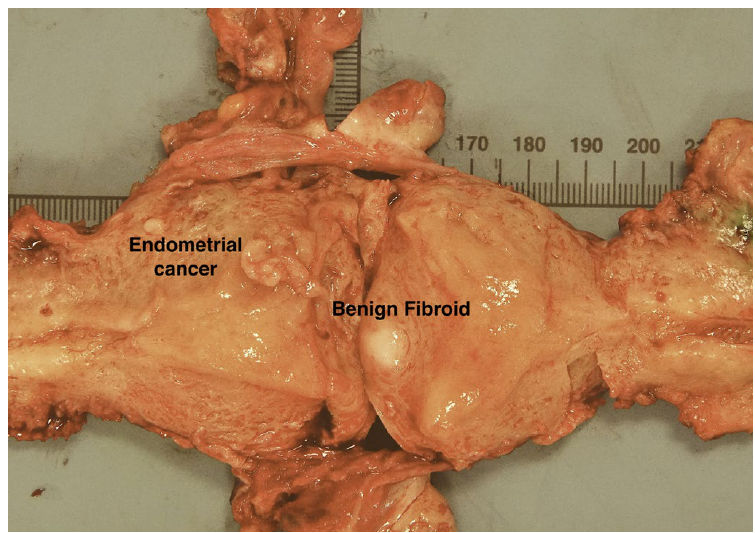
Figure 6. Case 2. Uterus bisected along its lateral walls showing a fleshy polypoid endometrial carcinoma arising from the left lateral fundus, in the region of the left cornua. The bulk of the tumour was removed during diagnostic hysteroscopic endometrial curettage. Scale is in mm. Collectively, these results are consistent with the preop urine MSI signal being from the tumour, and subsequent analysis of VAFs within the preop, postop, and tumour bi- opsy samples estimated that over 60% of the cfDNA in the initial preop urine was tumour- derived (Figure 5B). In addition, only the first preop urine, vaginal swab, and tumour samples were classified as MSI-H, with all other urine samples and control tissues classi- fying as MSS (Figure 5C). 4. Discussion We have shown that an mPCR amplicon sequencing assay can classify CRC MSI sta- tus and detect BRAF variants with a high level of concordance relative to existing diag- nostic methods, and that it can be used to detect MSI in colonoscopic biopsies. Knowledge of biopsy MMR status could facilitate clinical decision making and LS diagnosis, and establish the MMR status of tumours where surgery is not performed. Our original MIP assay classified CRCs with as little as 3% MSI-H template in mixing experi- ments [31], and composite biopsy templates analysed here gave assay scores comparable to matched resected tumour samples chosen via pathology triage for high tumour cell content. Composite samples could, therefore, potentially be used for MSI analysis without prior assessment. The method could also enable expansion of LS screening to adenomas removed during routine colonoscopic investigation, as MMRd/MSI often precedes ade- noma formation in LS patients (e.g., [50–52]), and it has been estimated that 69.5% of con- ventional adenomas in LS patients are MMRd/MSI-H [53]. However, data from only 4 LS patients have been analysed here, so it will be important to investigate adenomas and